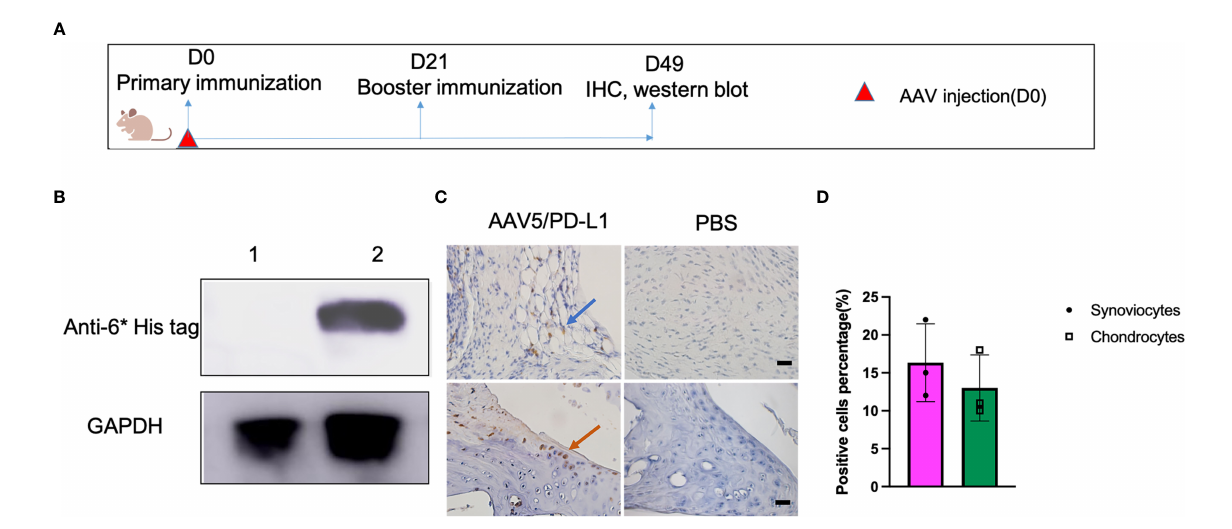
FIGURE 2 High PD-L1 expression in knee joints treated with AAV5/PD-L1 vectors. (A) , Schematic diagram of animal experiment. On day 0, AAV5/PD-L1 vectors at a dose of 1x10 10 particles were injected in CIA mouse model into the left knee, and PBS into the right knee of the same CIA mice. On the same day, type II collagen was injected into the mouse tail root as the primary immunization, followed by booster immunization on day 21. Joints were collected for PD-L1 detection on day 49. (B) , Western blot of PD-L1 expression in knee. Knee joints from both left knee (AAV5/PD-L1 injection) and right knee (PBS) were lysed and the supernatant was collected for PD-L1 protein detection by western blot using mouse anti-6*His tag antibody. Data shown is representative of 3 independent experiments. (C) , Immunohistochemistry staining for cells transduced by intra-articular injection of AAV5/PD-L1 vectors. Representative images are shown with anti-6* His positive cells in AAV5/PD-L1 treated mouse knees (left) and PBS treated mouse knees (right) (n=3, bar=20 m m). The blue arrow indicated positively stained synoviocytes, the orange arrow indicated positively stained chondrocytes. (D) , PD-L1 expression cell percentage in AAV5/PD-L1 treated joints. Three knee joints were analyzed in each group, the positive PD- L1 cells were counted from 10 fi elds of view and averaged. Each dot represents one mouse joint. The data is represented by mean and standard derivation. Data was analyzed by two-tailed paired student ’ s t